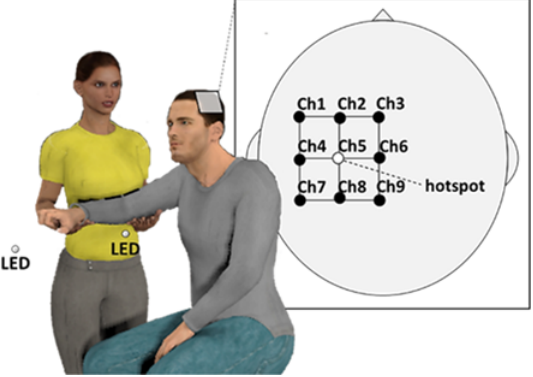
Figure 1. Experimental design used to evaluate rhythmic passive movements. EEG electrodes were placed over a nine ‐ position grid (5 × 5 cm 2 ); the center was oriented on the TMS hotspot of the biceps brachii muscle. Two LED lamps were placed 0.25 m and 0.75 m from the right acromion of the participant. Passive movements included elbow flexion and extension in response to the blinking of the LED lamps: EEG, electroencephalography; TMS, transcranial magnetic stimulation; LED, light ‐ emitting diode. Ch, channel.